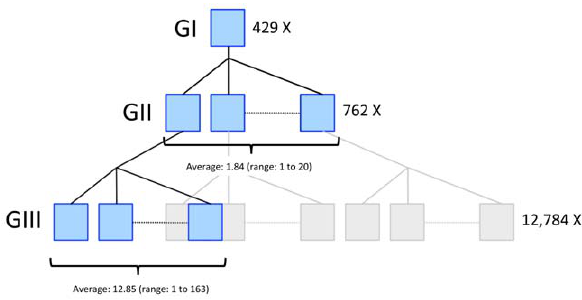
Figure 1. Three-generational pedigrees used to map genetic determinants of variation in male recombination rate in cattle. 10,192 (Dutch population) and 3,783 (NZ population) bulls, genotyped for 50K SNP panels, assorted in 429 three-generational pedigrees of the kind illustrated. All Dutch bulls were from the Holstein-Friesian breed, while in NZ 61% of the bulls were Holstein-Friesian and 39% Jerseys. Each pedigree is composed of one grand-sire with 1.84 GII sons on average (range: 1 to 20). Each GII sire has 12.85 GIII sons on average (range: 1 to 163). We have used the available SNP genotypes to identify 259,752 CO events that occurred in the sperm cells transmitted by the GII sires to their 10,106 GIII sons. QTL affecting variation in recombination rates were mapped by exploiting linkage information (effect of the homologues transmitted by the GI grand-sires to their GII sons) and LD information (effect of haplotypes transmitted by the GI- grand-sires and ungenotyped GI-grand-dams to their GII sons).